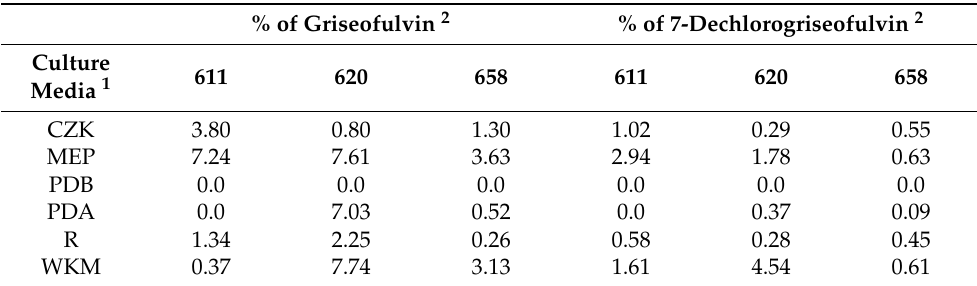
Table 1. Percentage ( w / w ) of griseofulvin and 7-dechlorogriseofulvin in all extracts obtained from fungi strain growth on different culture media. % of Griseofulvin